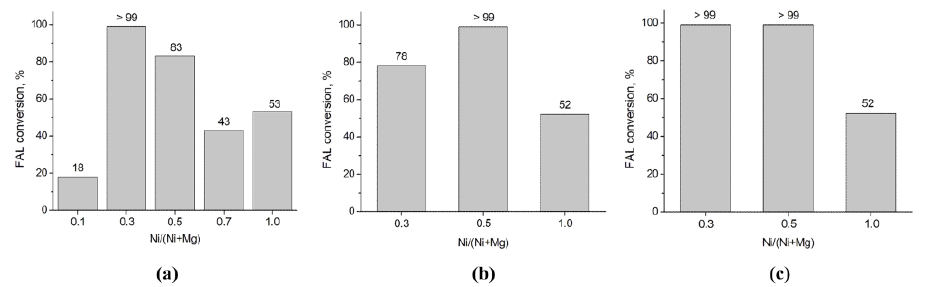
Figure 3. FAL conversion for the catalysts ( a ) (Ni + Mg)/Al = 2, ( b ) (Ni + Mg)/Al = 3, ( c ) (Ni + Mg)/Al = 4. Table 1. Results of FAL hydrogenation in the presence of Ni(Mg)Al-R catalysts with different